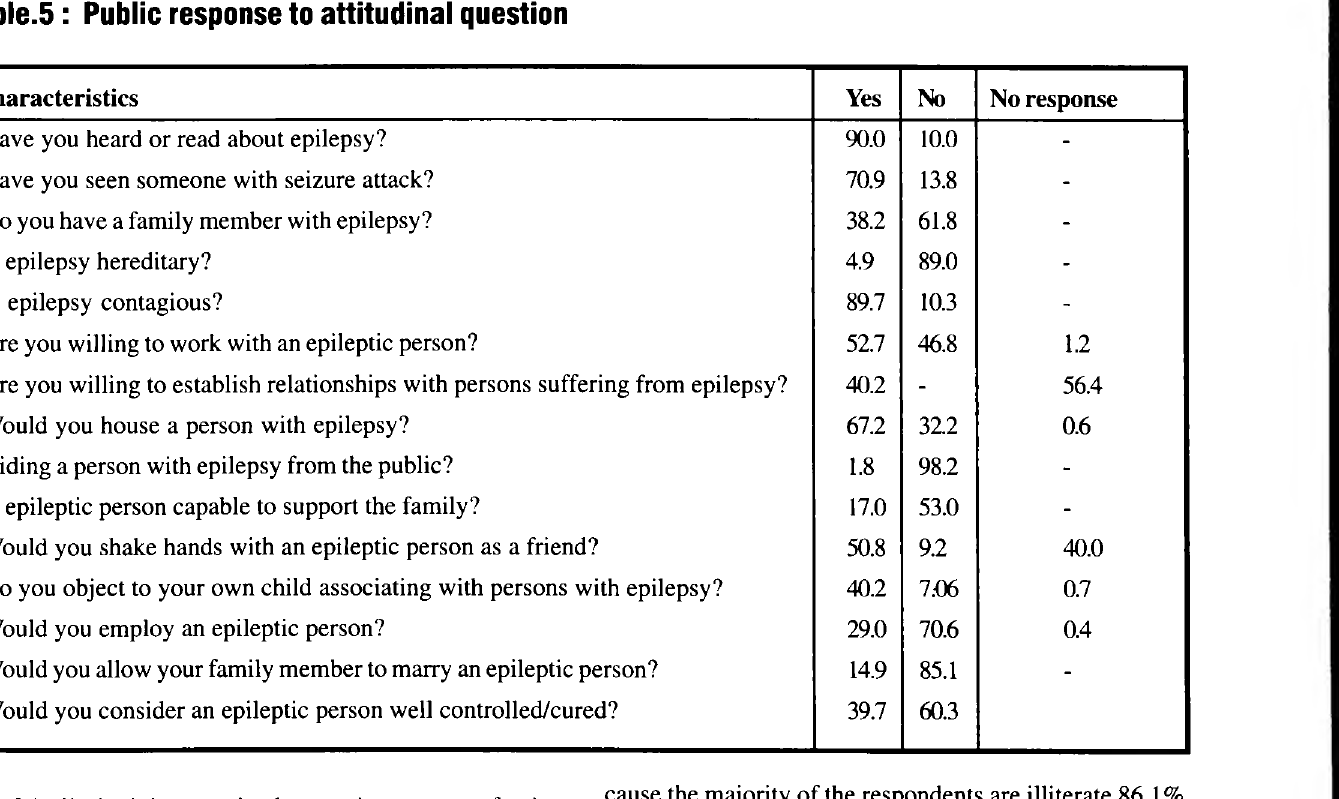
Table.5 : Public response to attitudinal question